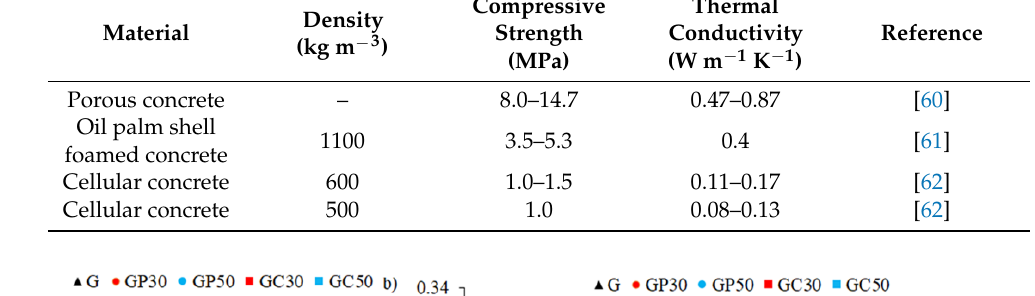
Table 6. Properties of concrete with porous structure according to different authors.